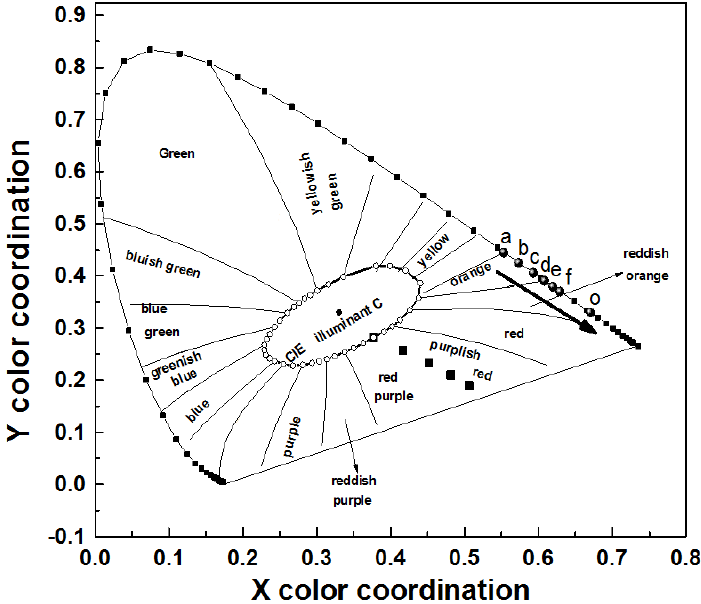
Figure 9. The chromaticity coordinates of LL 0.95 − y M:0.05Sm 3+ , y Eu 3+ ( y = 0 (a), 0.01 (b), 0.03 (c), 0.05 (d), 0.08 (e), 0.12 (f)) and the NTSC standard value point O.